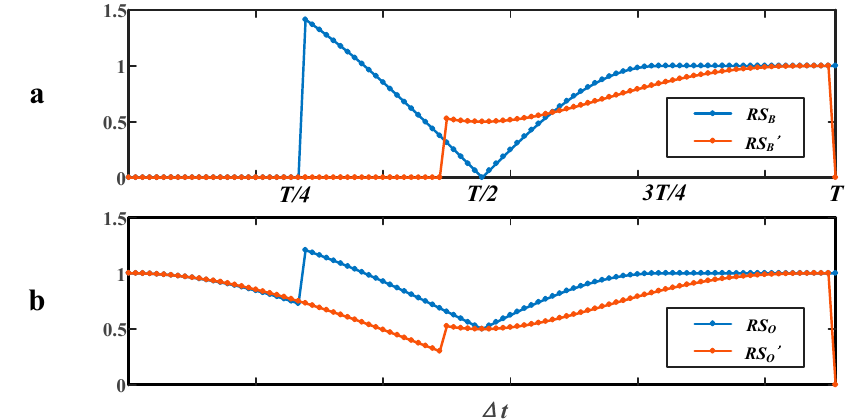
Figure 7. Comparation of relative size ( RS ) before and after a CC. ( a ) Debris B; ( b ) Overall.